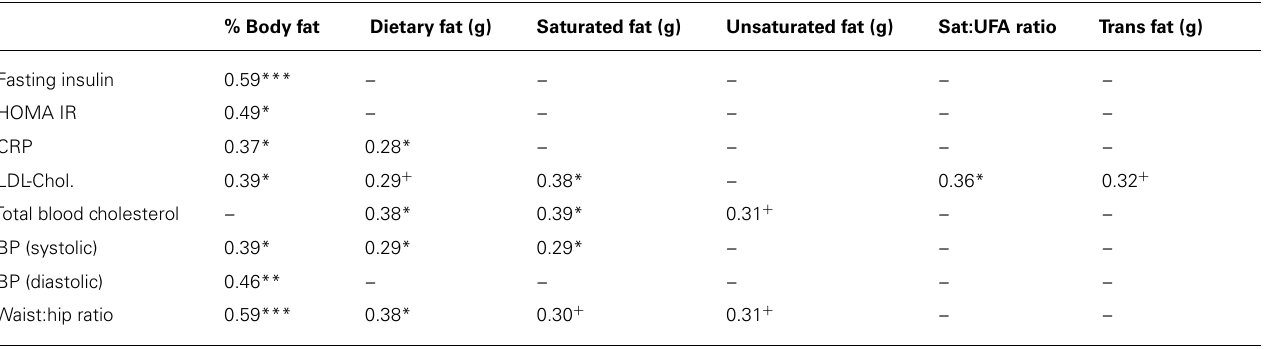
Table 3 | Correlations (Pearson’s r ) between % body fat, dietary fat intakes and physiological indices related to metabolic syndrome ( n = 38). % Body